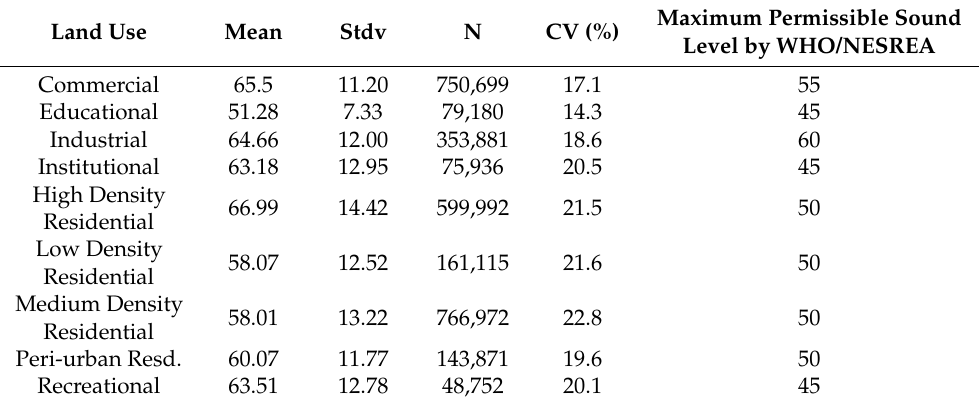
Table 3. General Distribution of Noise Land use type in